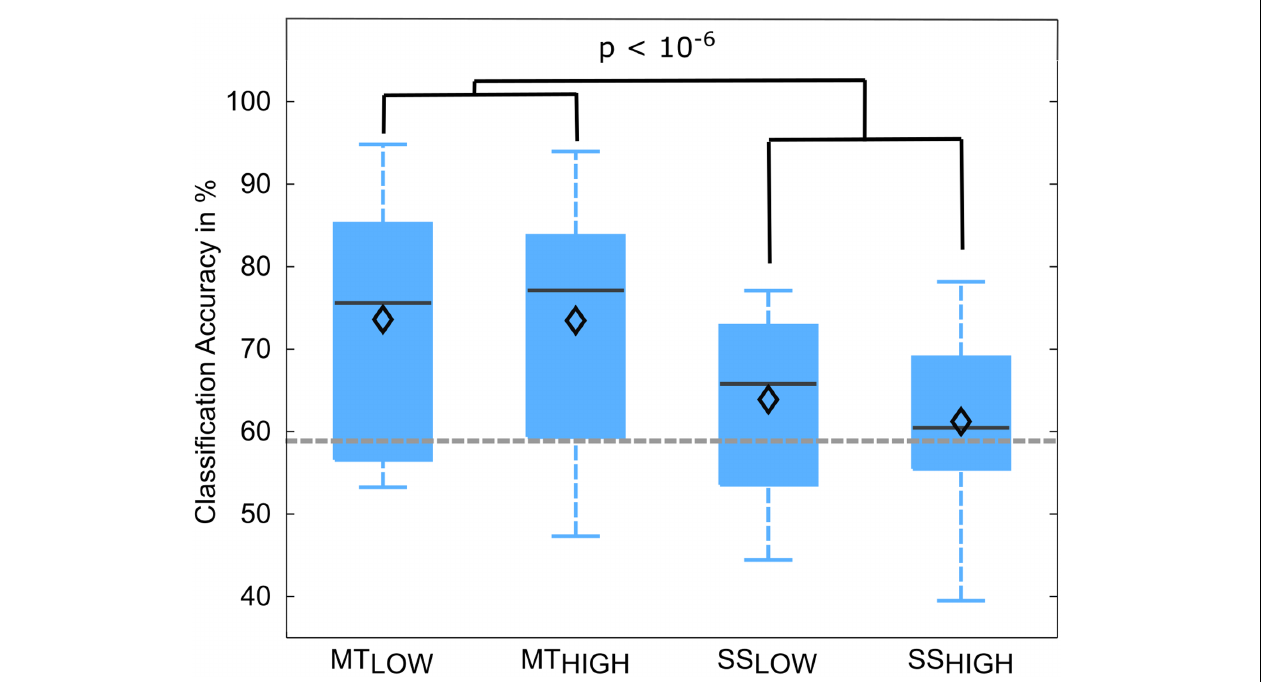
FIGURE 7 | Box plots depicting the classification accuracies of the four regular classifiers (RC) using alpha and beta band features averaged across all subjects. All classifiers performed a binary classification of an experimental condition vs. rest. Classifiers were trained and tested using a five-fold cross-validation. Each of these classifiers performed significantly above chance. MT classifiers reached significantly higher classification accuracies than sensory stimulation (SS) classifiers ( p < 10 − 6 ). The vertical dotted gray line depicts the statistical chance level (58.9%). Mean classification accuracies are depicted by the diamond. Central lines within the boxes represent the median.